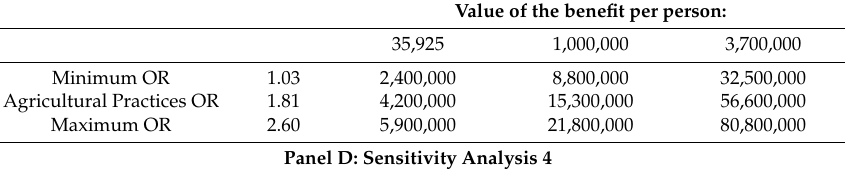
Table 4. Cont . Panel C: Sensitivity Analysis 3 Value of the benefit per person: 35,925